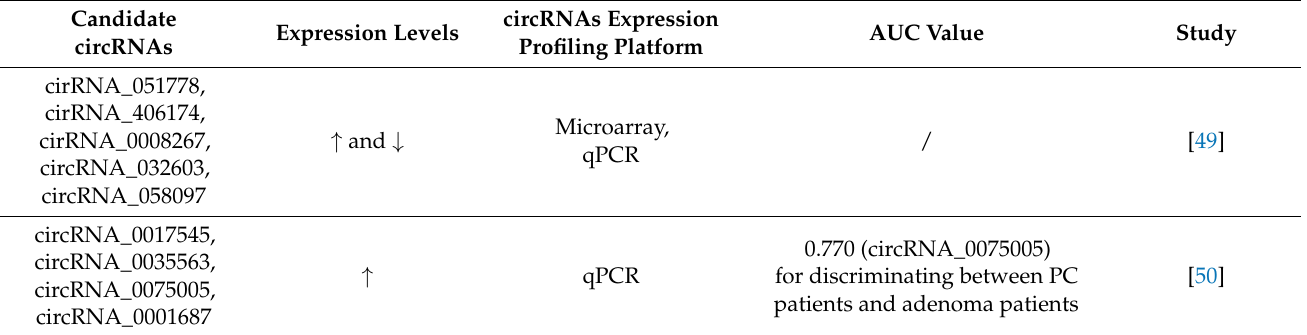
Table 3. Summary of differentially expressed circRNAs in parathyroid